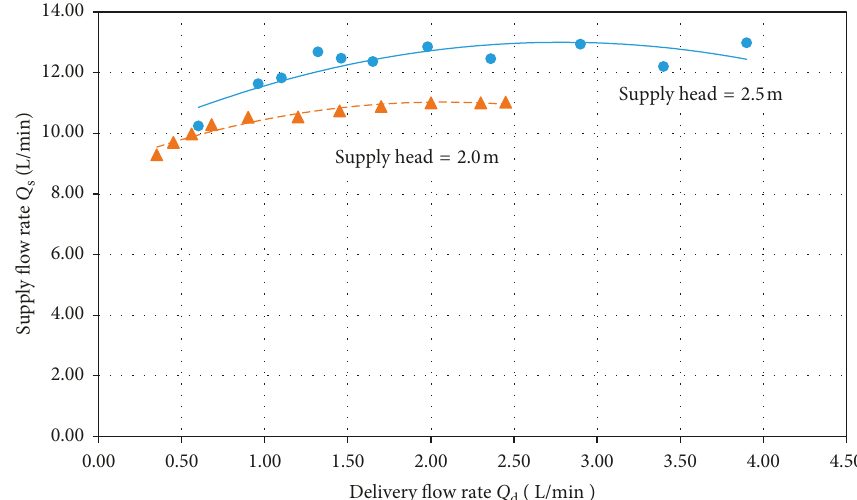
Figure 3: Supply flow rate vs. delivery flow rate at difference head, h